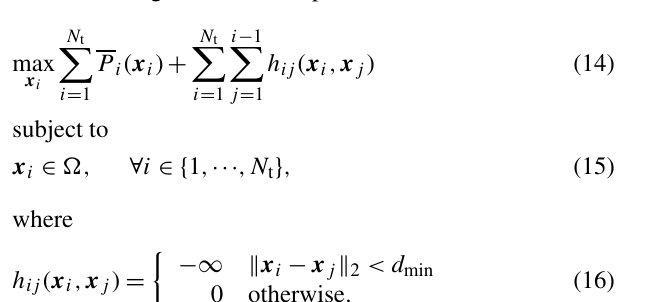
Table 2. Large Eddy Simulation results for different wind-farm layouts. Power output normalized with respect to total power of a wind-farm consisting of ‘first-row’ turbines. Average LES power is 69 . 97% . Case